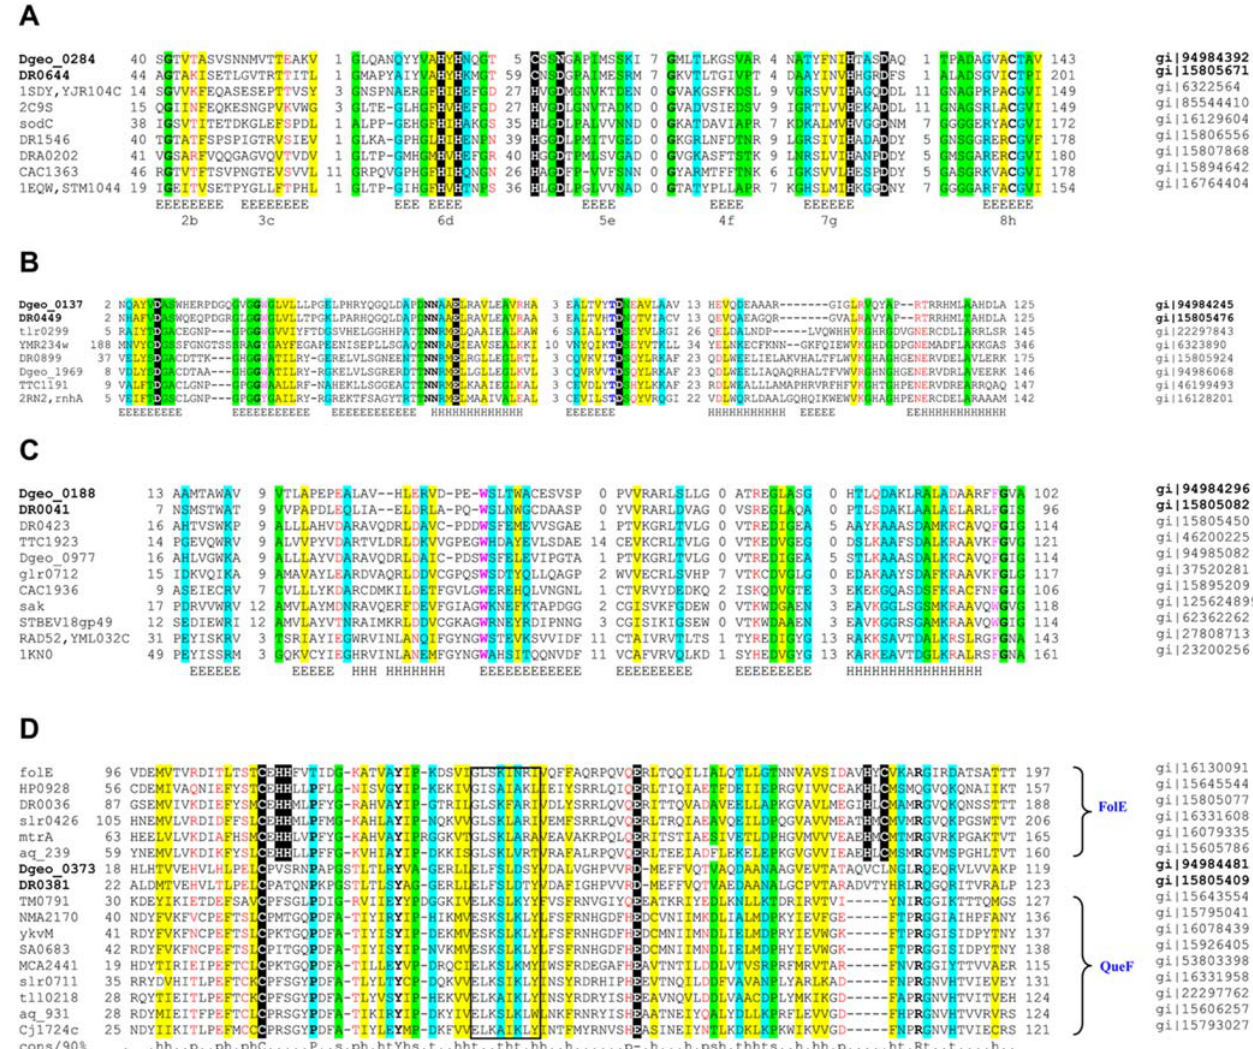
Figure 5. Multiple alignments of selected families conserved in two Deinococcus species. The multiple alignments were constructed for selected representative sets of sequences by the MUSCLE program [ 154 ] . Where necessary, alignments were modified manually on the basis of PSI- BLAST outputs [94]. The positions of the first and the last residue of the aligned region in the corresponding protein are indicated for each sequence. The numbers within the alignment refer to the length of inserts that are poorly conserved between all the families. Secondary structure elements are denoted as follows: E- b -strand; and H- a -helix. The coloring scheme is as follows: predominantly hydrophobic residues are high-lighted in yellow; positions with small residues are in green; positions with turn-promoting residues are in cyan; positions with polar residues are in red; hydroxyl-group containing residues are in blue; aromatic residues are in magenta; and invariant, highly conserved groups are in boldface. A , DR0644-Dgeo_0284 conserved pair of orthologs belong to the copper/Zinc superoxide dismutase family; shaded letters refer to amino acids that play an important role in the Cu 2 + /Zn 2 + coordination environment and in the active site region. The bottom line shows the correspondence between the most conserved regions corresponding to the b -stand structural core and conserved in most family members as denoted in Bordo et al [157]. B , Dgeo_0137-DR0449 are highly specific for the Deinococcus lineage proteins that have an RNAse H-related domain. Catalytic residues conserved in the RNAse H family are shaded. Secondary structure elements are shown for E. coli RNase HI (PDB:2rn2). C , DR0041-Dgeo_0188 is another conserved pair (DdrA-related) of proteins belonging to the Rad52 family of DNA single-strand annealing proteins [97]. Secondary structure elements are shown for human RAD52 (PDB:1KN0) [158]. sak is a phage gene described previously [159]; D , DR0381-Dgeo_0373 are diverged homologs of NADPH-dependent nitrile reductase (GTP cyclohydrolase I family) that might be involved in nucleotide metabolism. The conserved Cys and Glu found in the substrate binding pocket of both protein families and specific zinc-binding and catalytic residues in the FolE family are shaded. The QueF family motif is boxed. Other catalytic residues in FolE not found in QueF are in yellow. Genbank Identifier (gi) numbers are listed on the right. doi:10.1371/journal.pone.0000955.g005 resistance. Notably, we continue to find proteins in Deinococcus (Figure 5C); and a member of the RAD22/Rad52 family species which are only remotely similar to well-characterized (Figure 5C) of single-stranded annealing proteins [97], that yields enzymes in other organisms, and it is difficult to predict their role a moderately sensitive phenotype in D. radiodurans upon disruption in the cell or radiation resistance. For example, we have identified [98]. Interestingly, the radiation-sensitive T. thermophilus encodes a protein that is conserved in both D. geothermalis and D. radiodurans a homolog of DdrA (TTC1923), indicating that this protein had and is distantly related to enzymes of the QueF/FolE family, an ancestral role that was not directly related to radiation which are involved in queuosine/folate biosynthesis (Figure 5D),